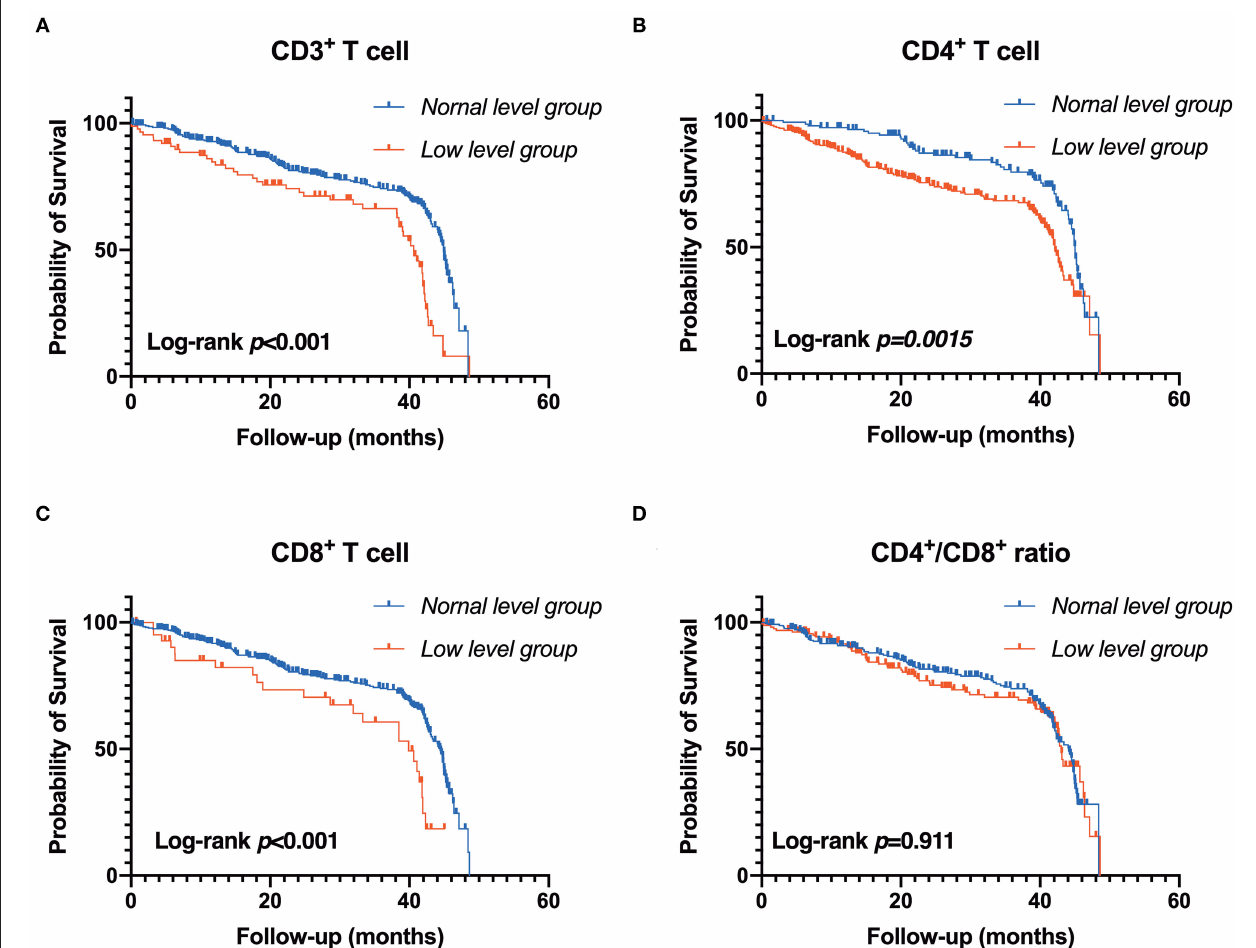
FIGURE 4 | Association between T-lymphocyte subsets and renal outcome. (A) CD3 + T cell, (B) CD4 + T cell, (C) CD8 + T cell, (D) CD4 + /CD8 + T cell. Patients were stratified into two groups by clinical reference value (Kaplan-Meier analysis with log-rank